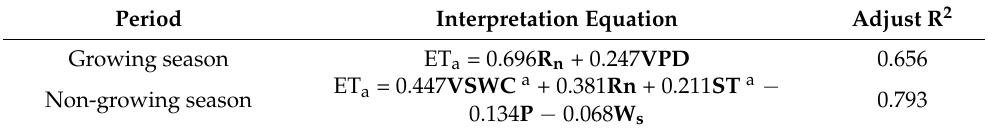
Table 2. Results of the stepwise regression.